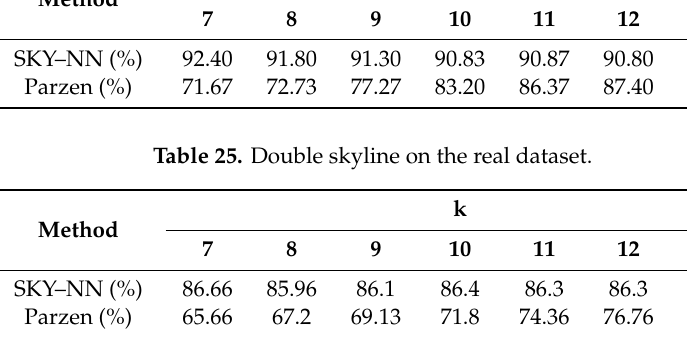
Table 26. Opposite skyline on the real dataset.